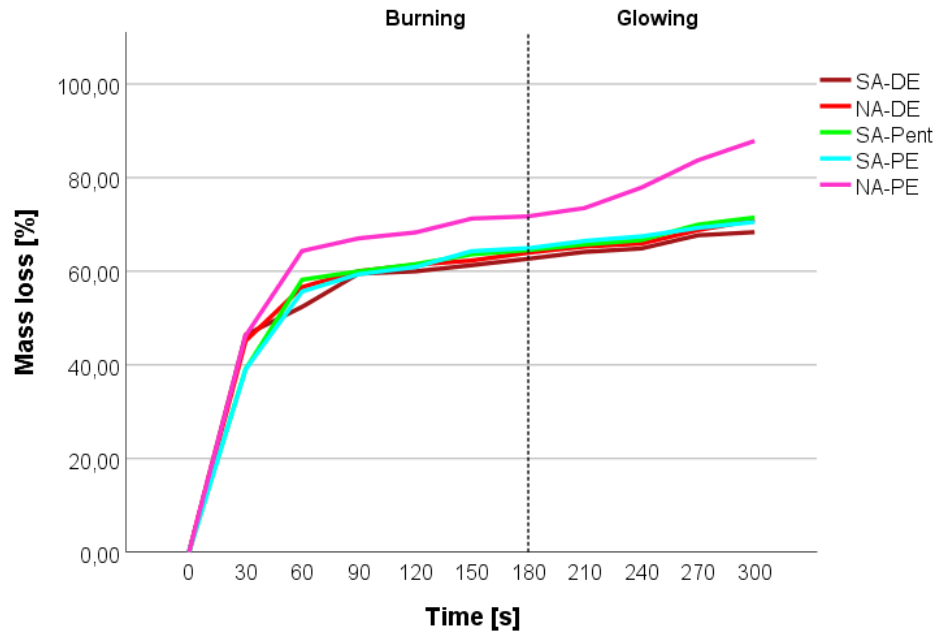
Figure 6. Mass loss of the tannin foams during direct flame exposure: burning and glowing phases.